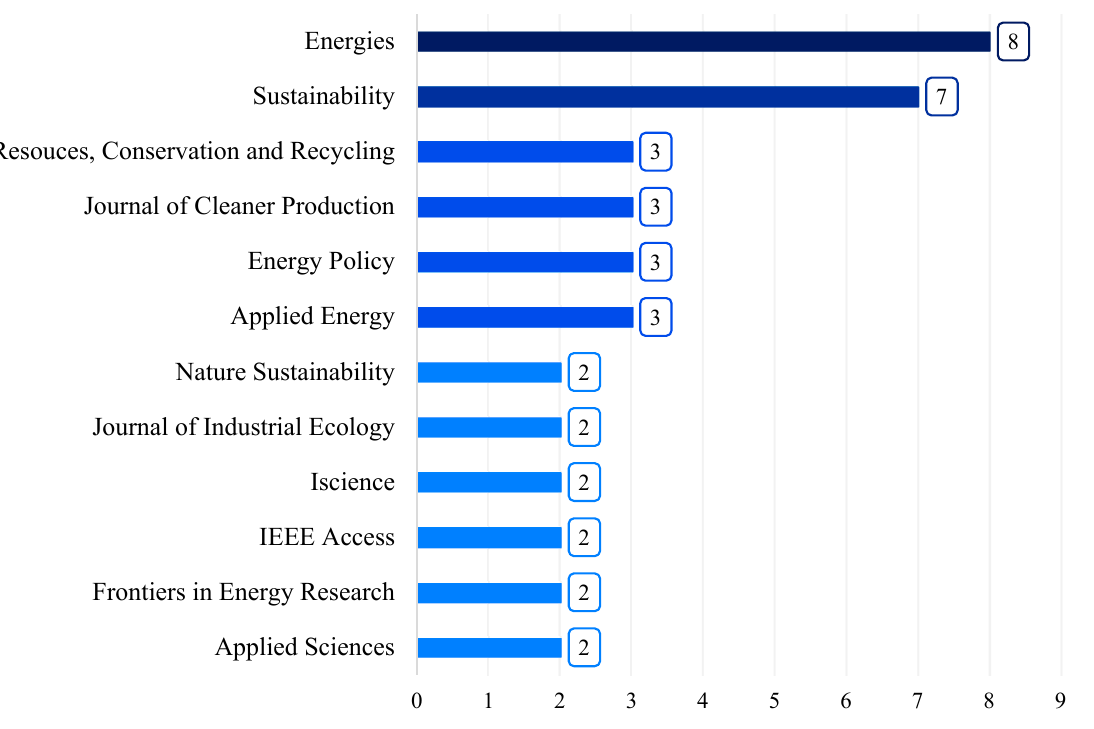
Figure 7. Number of publications of the most relevant journals. (Chart produced in Microsoft Excel).